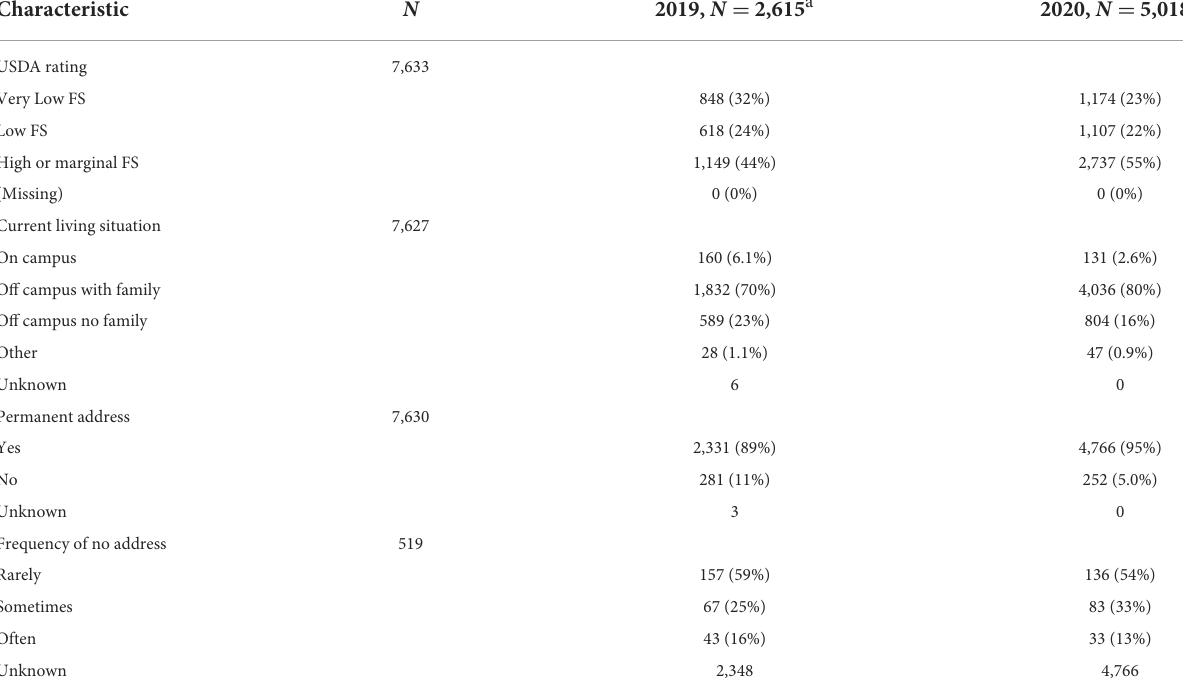
TABLE 1 Overall levels of food and housing